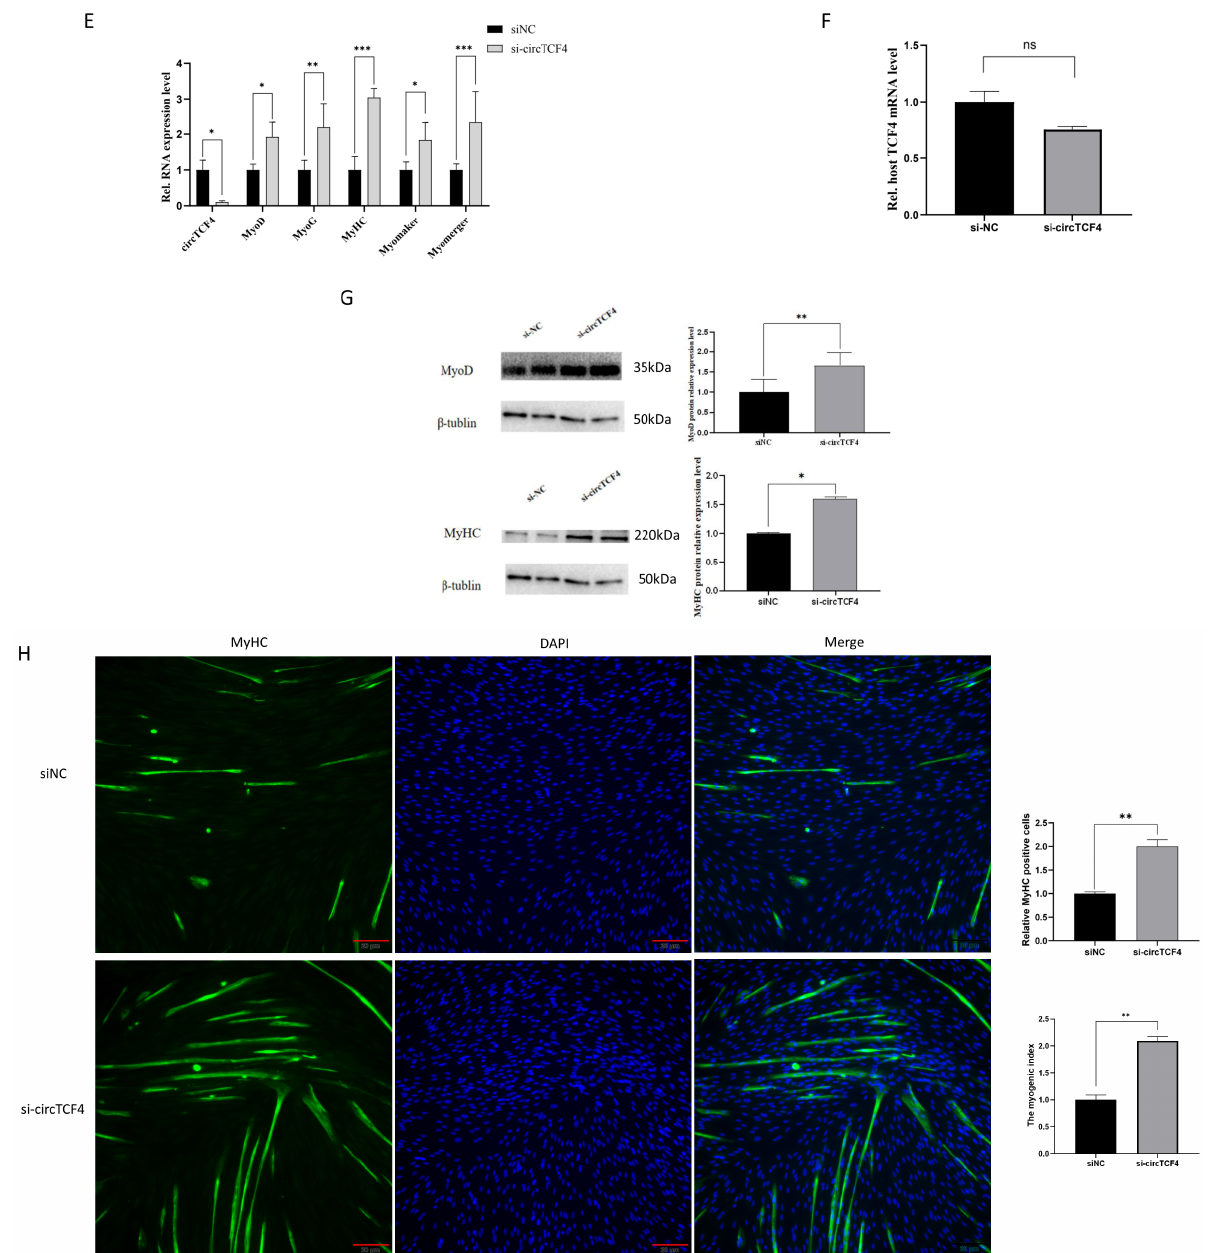
Figure 4. Effect of interference with circTCF4 on the differentiation of MuSCs. ( A ) Expression of circTCF4 and myogenic differentiation marker genes (Myomaker, MyHC, Myomerger, MyoD, and MyoG) after overexpression of circTCF4. ( B ) levels TCF4 mRNA after circTCF4 overexpression. ( C ) MyoD and MyHC protein levels after overexpression of circTCF4. ( D ), MyHC-stained myofibers after overexpression of circTCF4 and statistical results of MyHC-positive cells and myogenic index after overexpression. ( E ) levels of circTCF4 and MuSCs differentiation marker genes (Myomaker, MyHC, Myomerger, MyoD and MyoG) transcripts altered by circTCF4 deficiency. ( F ) TCF4 mRNA expression after circTCF4 interference. ( G ) MyoD and MyHC protein levels changed by circTCF4 interference. ( H ). MyHC-stained myofibers affected by circTCF4 deficiency and statistical results of MyHC positive cells and myogenic index after interference with circTCF4. Data are means ± standard error from at least three biological replicates, * p < 0.05, ** p < 0.01, and *** p <